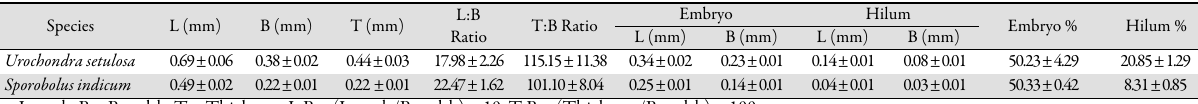
Table 2. Morphometric analysis of caryopses in Urochondra setulosa and Sporobolus indicus